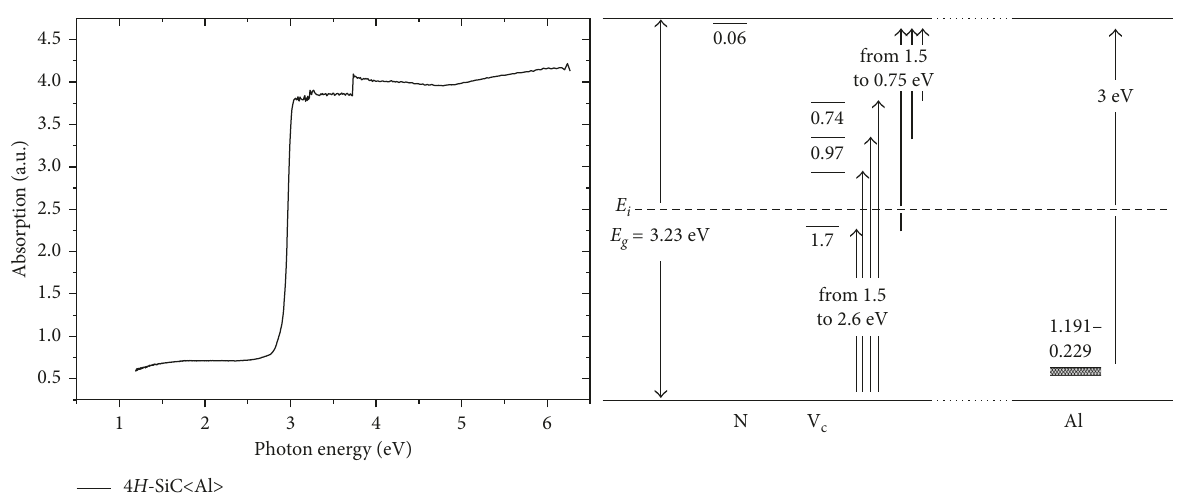
Figure 4: The optical absorption spectrum of p-n -4 H -SiC structures doped with aluminum (from a source created by using aluminum chloride) measured at room temperature and a diagram of optical absorption